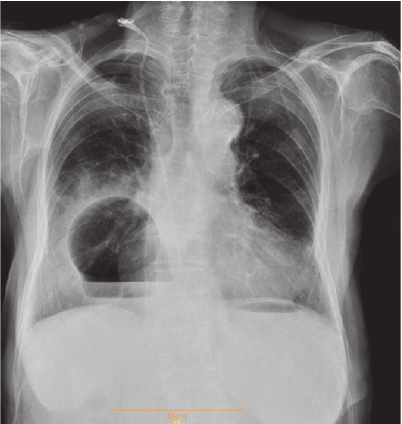
Figure 4: Excision of the